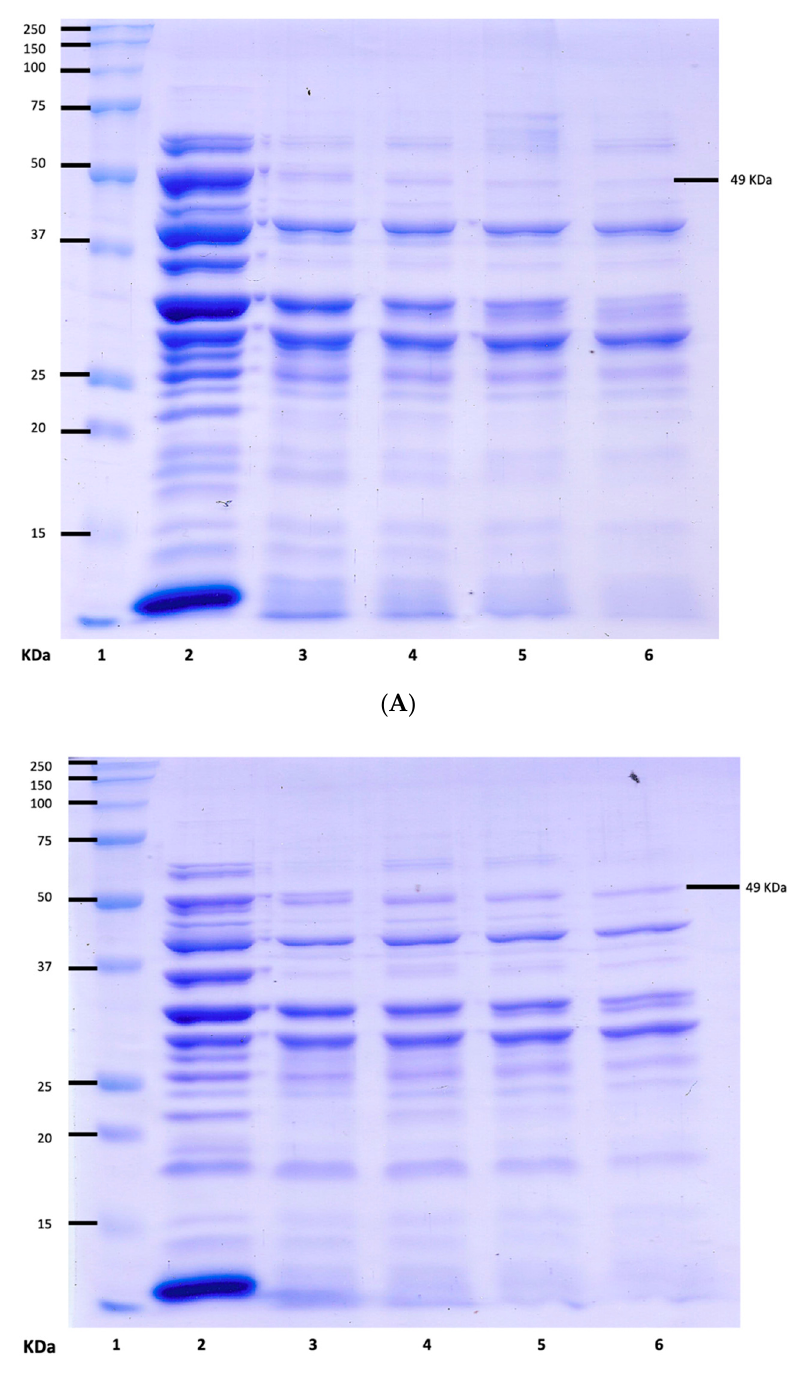
Figure 7. SDS-PAGE of undigested and digested ( A ) Wt 8S α globulin and ( B ) Mut2 8S α globulin. Lanes—1: protein marker, 2: undigested sample, 3: 2-h digest, 4: 6-h digest, 5: 12-h digest, and 6: 24-h digest.